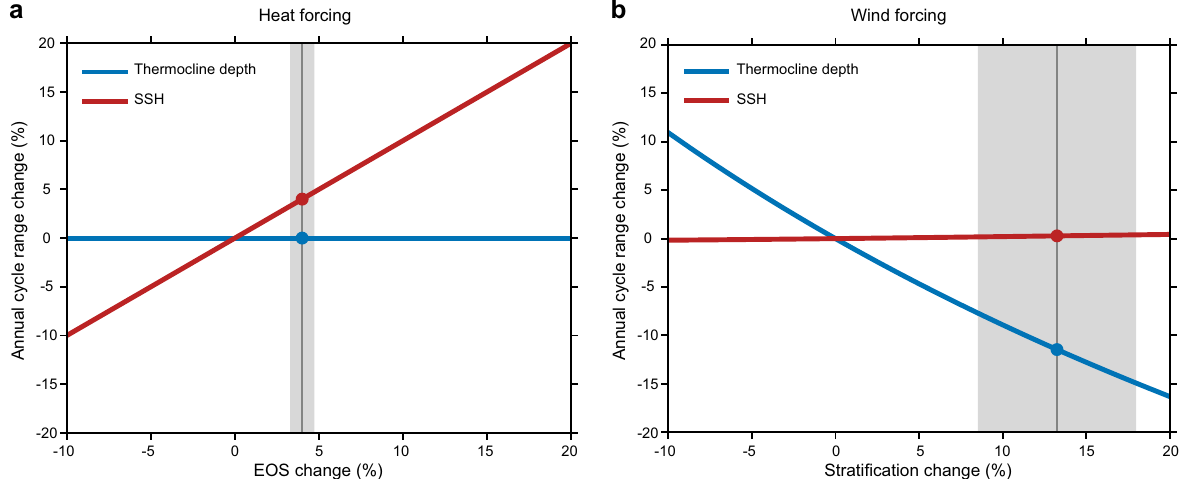
Fig. 7 With constant annual cycle forcing of heat (a) or wind (b), future change of the annual cycle ranges ( y -axes; %) of SSH (red) and thermocline depth (blue) from analytical solutions to various changes in the seawater EOS or ocean strati fi cation ( x -axes; %). CMIP5 future projected changes of the EOS ( a ) or strati fi cation ( b ) in the subtropical region of the North Paci fi c (15°N – 35°N, 140°E – 120°W domain averages of Fig. 4a and Supplementary Fig. 7, respectively) are indicated by the vertical lines (multi-model mean) and shading (inter-model spread, ±1 standard deviation). The latitude-longitude varying solutions corresponding to the domain averages in ( b ) (wind forcing experiment) are shown in Supplementary Fig.